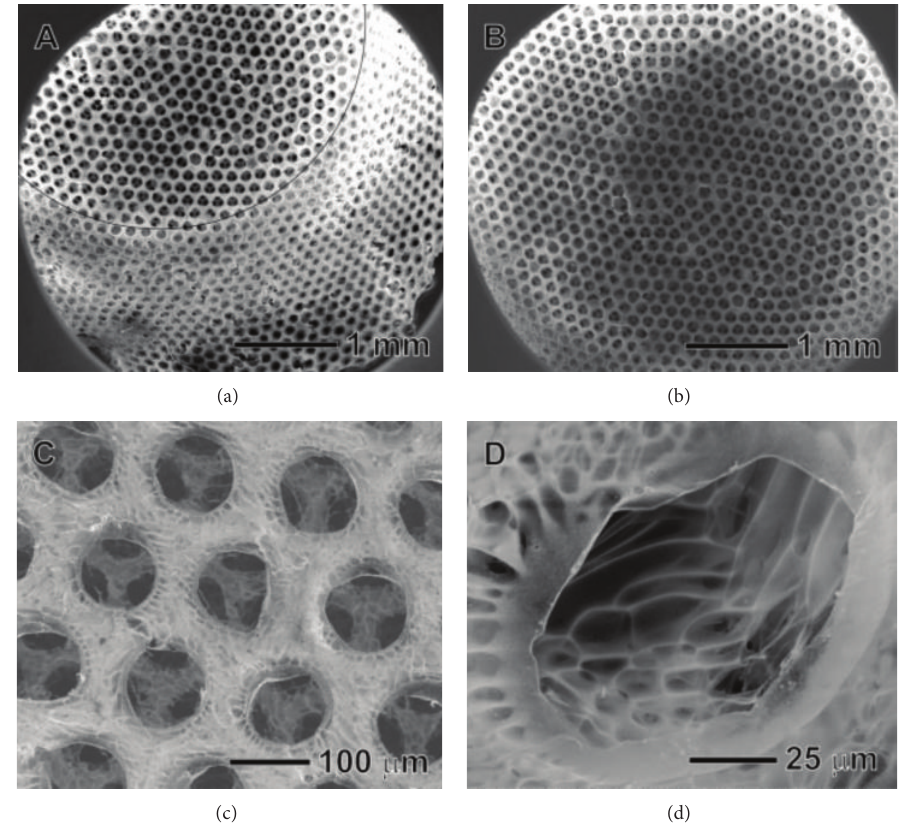
Figure 14: SEM images of the chitosan inverse opal scaffold: (a) side view, (b) top view, (c) a magnified view of the top surface, and (d) a magnified view of the side wall in a pore. The black line in (a) represents the edge of the scaffold [56].